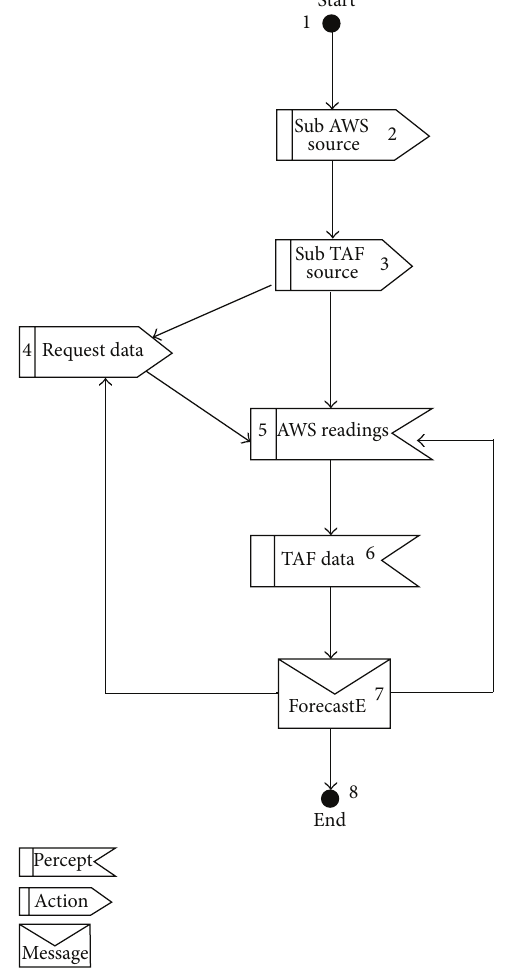
Figure 3: Protocol graph for data retrieval protocol diagram.